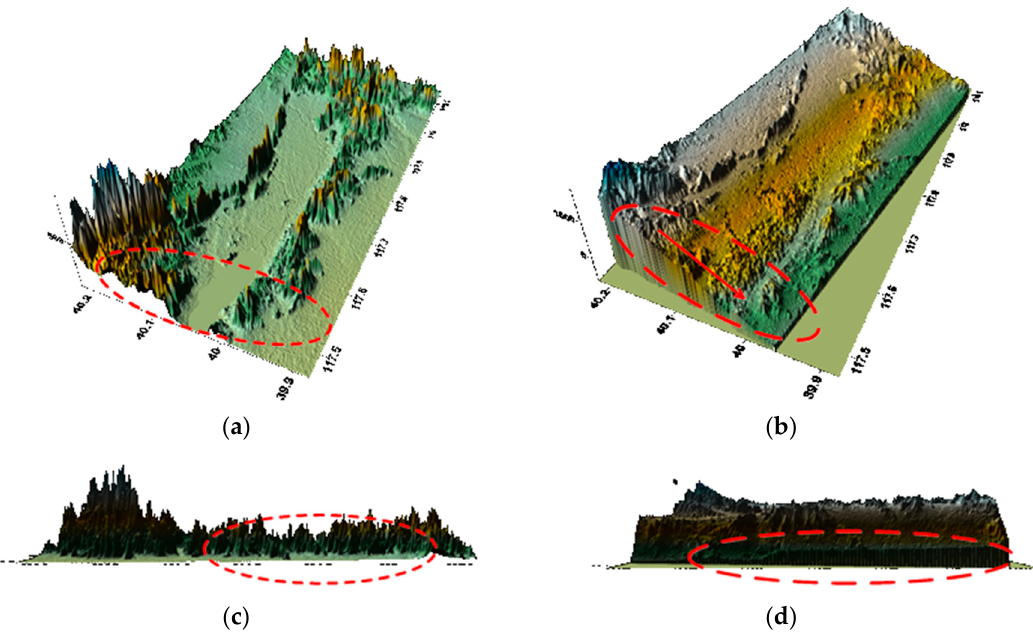
Figure 10. DEM product after orbit fitting: ( a ) SRTM DEM along the latitude; ( b ) GF-3 generated DEM along the latitude; ( c ) SRTM DEM along the longitude; ( d ) GF-3 generated DEM along the longitude.